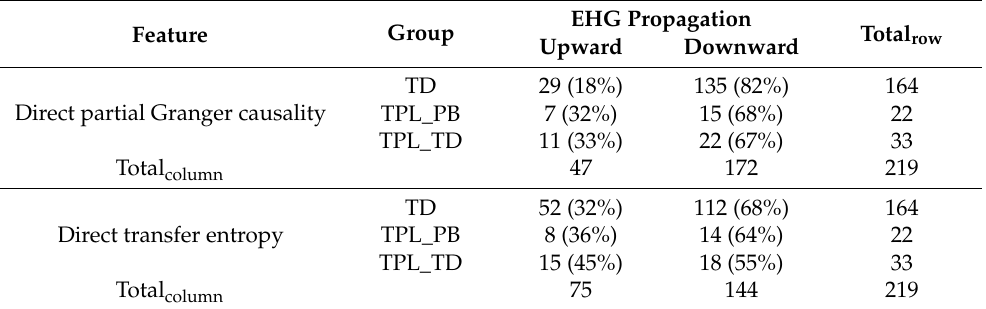
Table 2. Number (%) of pregnant women with upward or downward propagation in the group of different labors.